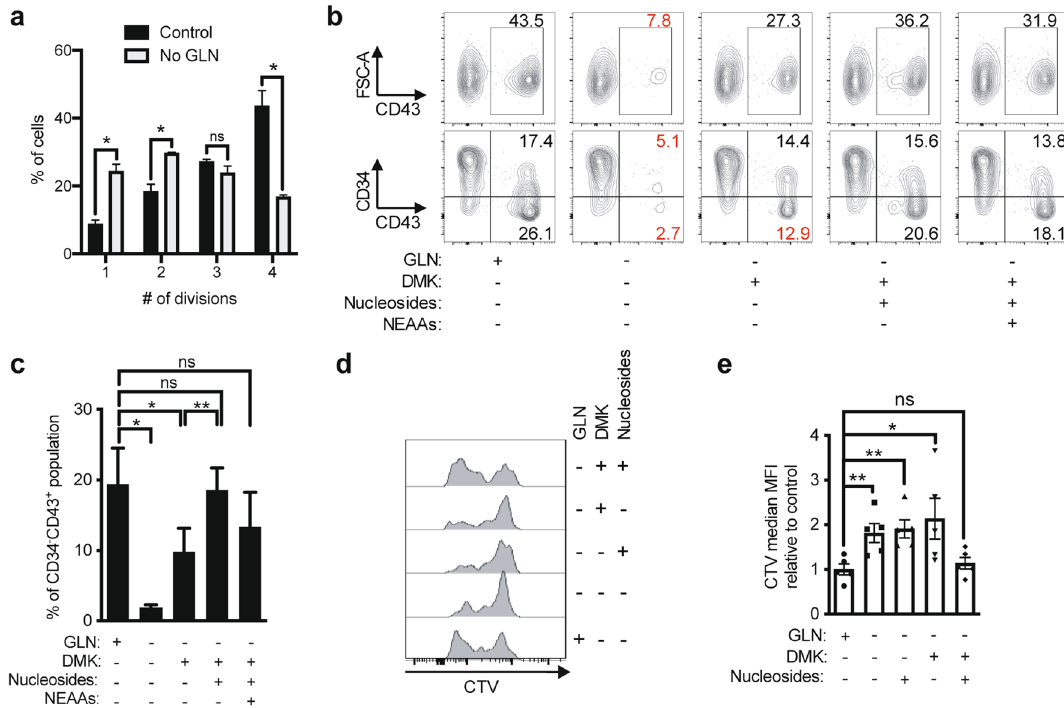
Figure 2. Glutamine is essential for the proliferation of differentiating cells during EHT. ( a ) Day 8 FACS- sorted EHT cells were stained with CellTrace Violet (CTV) proliferation dye and subcultured with or without glutamine (2 mM). For each division stage, the percentage of EHT-derived CD43 + cells ± s.e.m. at day 3 are shown (n = 2, unpaired t -tests). See representative plots in Fig. S2b. ( b – e ) FACS-sorted HE cells were subcultured in glutamine-free medium with the indicated compounds: DMK (1.75 mM), Nucleosides or NEAAs. ( b , c ) Subculture day 3 representative plots showing the expression of FSC-A / CD43 and CD34 / CD43 are shown (n = 3, see ( c ) for bar graphs). ( d , e ) Subculture day 3 CellTrace Violet (CTV) fluorescence was assessed in total cells obtained from HE cells by flow cytometry (n = 4, see ( e ) for bar graphs). ns, not significant, * p < 0.05, ** p <